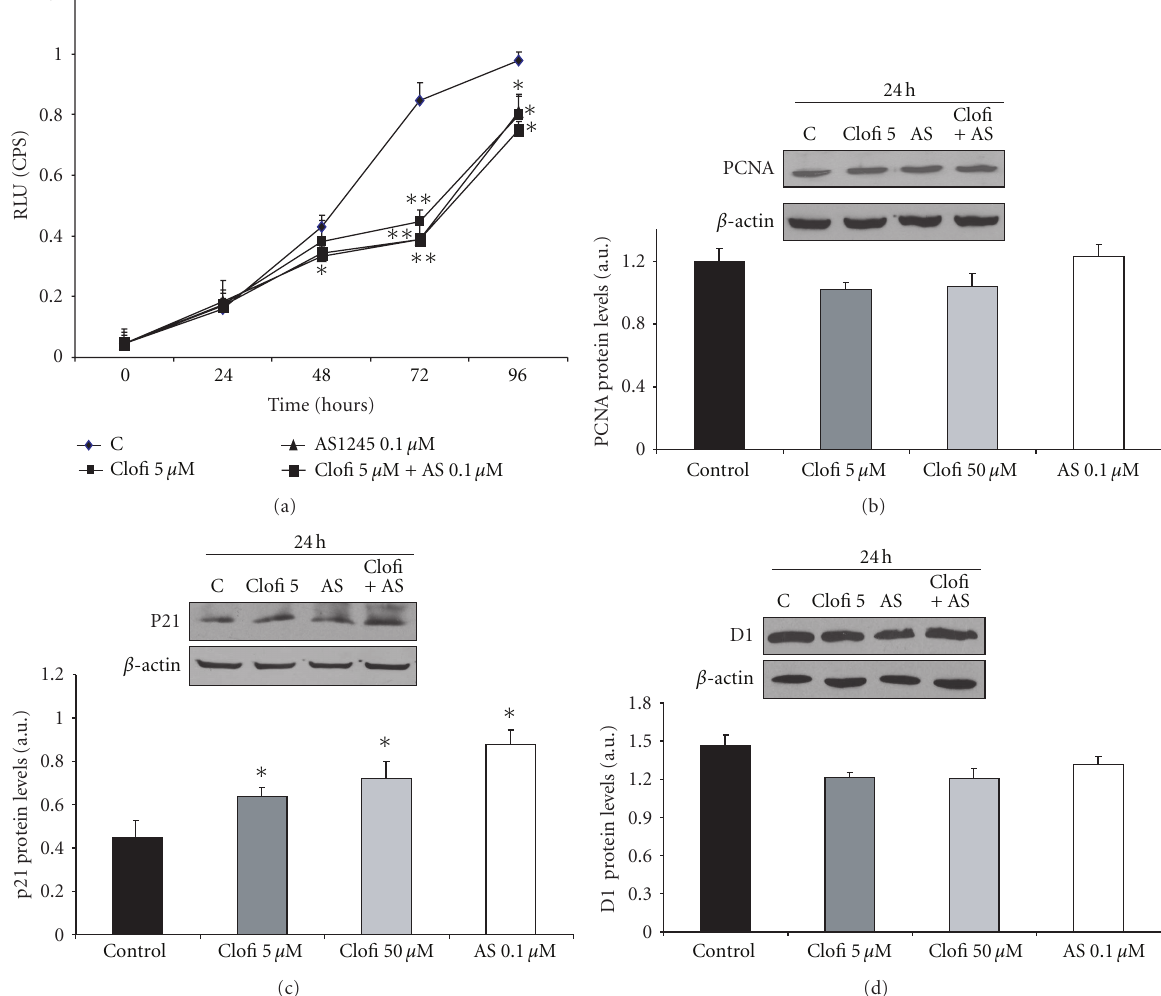
Figure 8: E ff ect of clofibrate and AS601245 in HepG-2 human liver cells. (a) Growth of HepG-2 cells treated with 5 μ M clofibrate, 0,1 μ M AS601245, and the association of these two compounds (Clofi + AS601245); (b) Western Blot analysis of PCNA detected in CaCo-2 cells treated with 5 μ M clofibrate, 0.1 μ M AS1245, and 5 μ M clofibrate plus 0.1 μ M AS601245 (Clofi + AS601245), collected at 24 hours after the treatment; (c) Western Blot analysis of p21, detected in CaCo-2 cells treated with 5 μ M clofibrate, 0.1 μ M AS1245, and 5 μ M clofibrate plus 0.1 μ M AS601245 (Clofi+AS601245), collected at 24 hours after the treatment; (d) Western Blot analysis of cyclin D1 detected in CaCo-2 cells treated with 5 μ M clofibrate, 0.1 μ M AS1245, and 5 μ M clofibrate plus 0.1 μ M AS601245 (Clofi + AS601245), collected at 24 hours after the treatment. Graphics represent the relative quantification of protein products performed by densitometric scanning. Data were normalized by using the β -actin signal, expressed as arbitrary densitometric units, and are the mean ± SD of three separate experiments from three di ff erent preparations for each condition. Variance analysis: ∗ P < 0 . 05, ∗∗ P < 0 . 01 versus